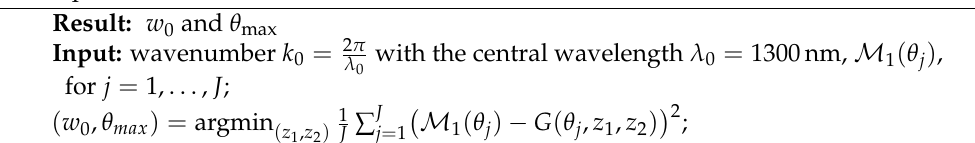
Algorithm 1: Extraction method for the beam radius w 0 and the angle θ max of acceptance.